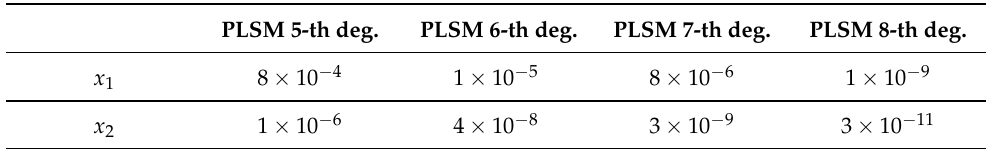
Table 6. Comparison of the maximal absolute errors of the approximate solutions x 1 (first row) and x 2 (second row) for problem (19) in the case α 1 = α 2 = 1. PLSM 5-th deg. PLSM 6-th deg. PLSM 7-th deg. PLSM 8-th deg. x 1 8 × 10 − 4 1 × 10 − 5 8 × 10 − 6 1 × 10 − 9 x 2 1 × 10 − 6 4 × 10 − 8 3 × 10 − 9 3 × 10 −